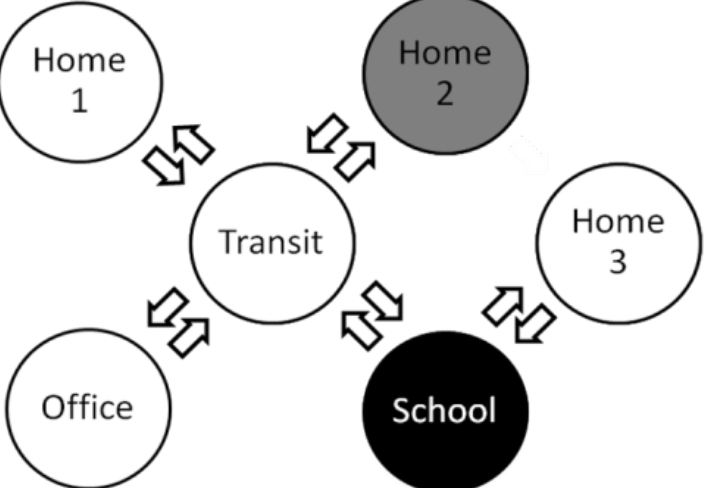
Figure 1: A schematics showing the social network made with nodes denoting center of social ac- tivities, such as schools, o ffi ces, public transit and households connected by human daily activities. In emergency, the closures of places with high connectivity, such as schools, are necessary. Schools (black circle) can be fully closed, and those a ff ected places, where infected cases are identified, like home 2 (grey circle) should be under surveillance and control (we denote the control strength as δ